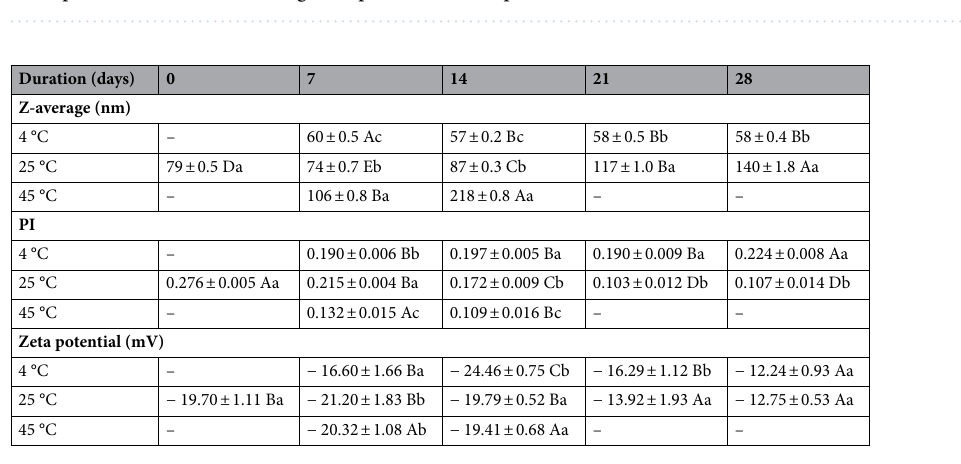
Figure 3. Representative TEM pictures of the optimized CEO-based nanoemulsion. ( a ) A droplet cluster. Scale bar represents 200 nm. ( b ) A single droplet. Scale bar represents 100 nm.